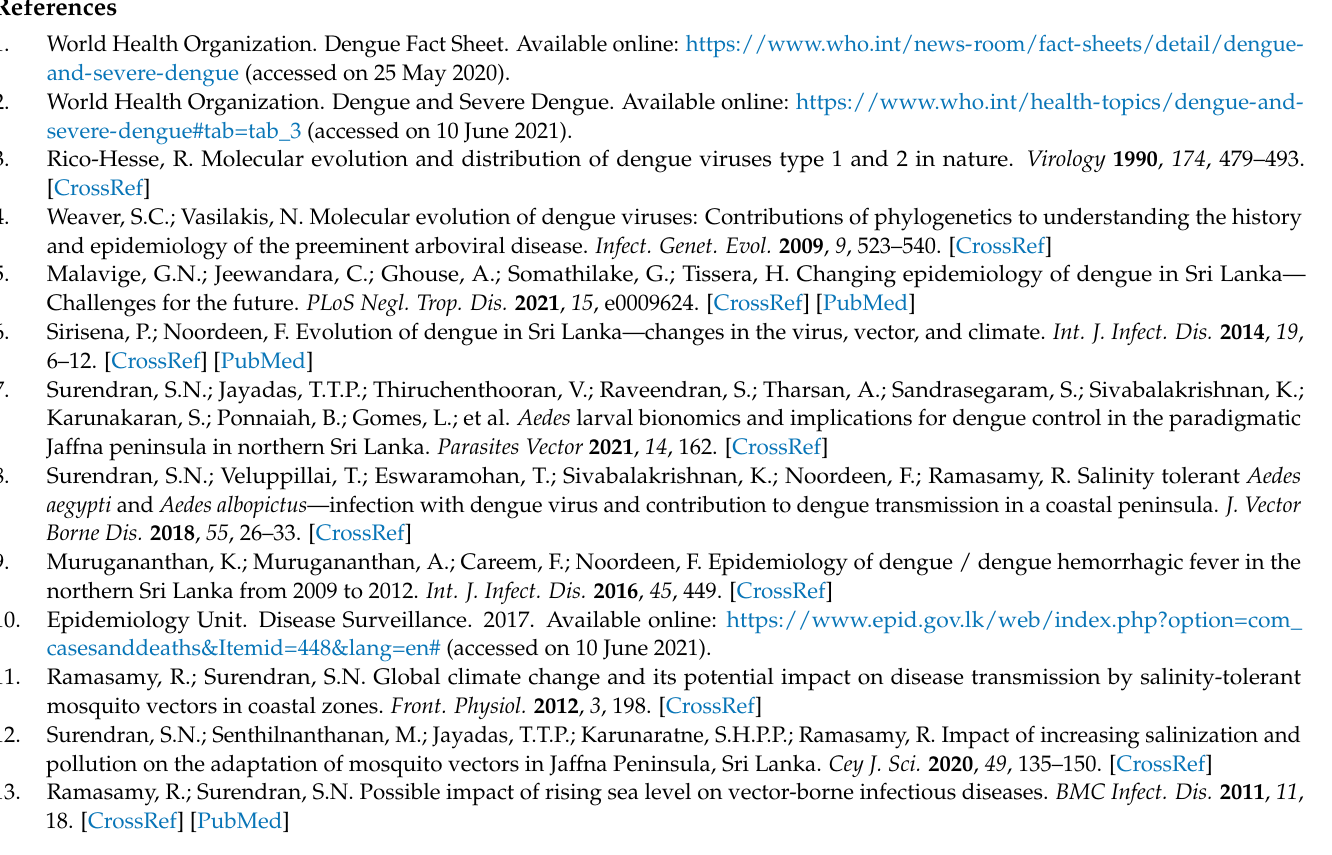
quences. Table S1: Clinical manifestations in relation to DENV serotypes. Table S2: Laboratory findings in relation to DENV serotypes. Table S3: Laboratory findings commonly used in dengue diag- nosis and their association with dengue fever (DF) and dengue hemorrhagic fever (DHF) in serotyped Jaffna